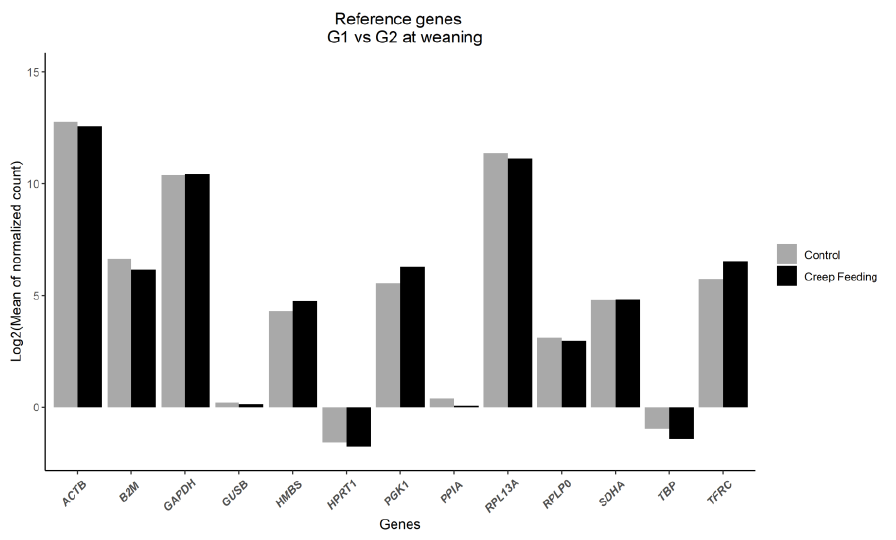
Figure 1. Expression profile of reference genes in the control group (G1, no creep feeding) and the group submitted to creep feeding (G2).